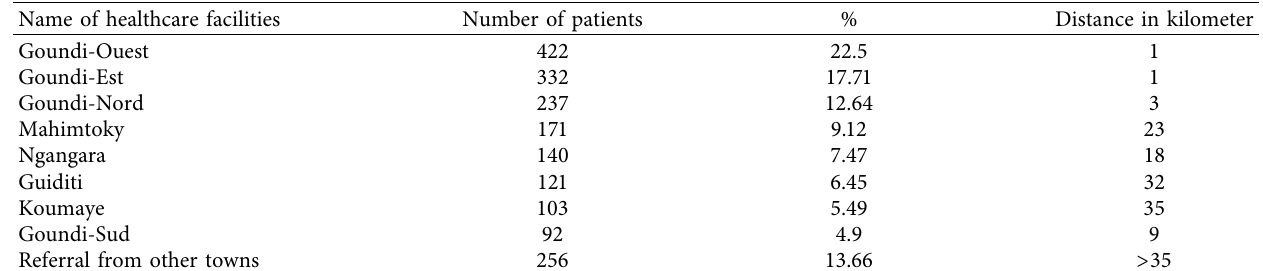
Table 2: Facilities’ origin of the study population.